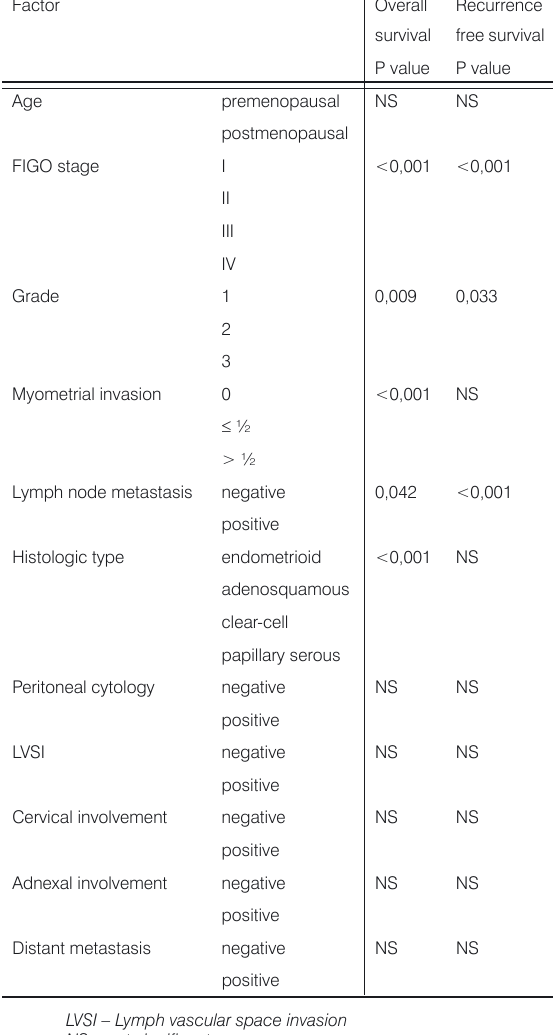
Table 5. Multivariate analysis of prognostic factors for overall an recurrence-free